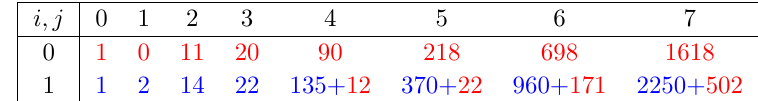
Table 20 . Coe(cid:14)cients c SU(3) for the unre(cid:12)ned elliptic genus of three SU(3) instanton i;j